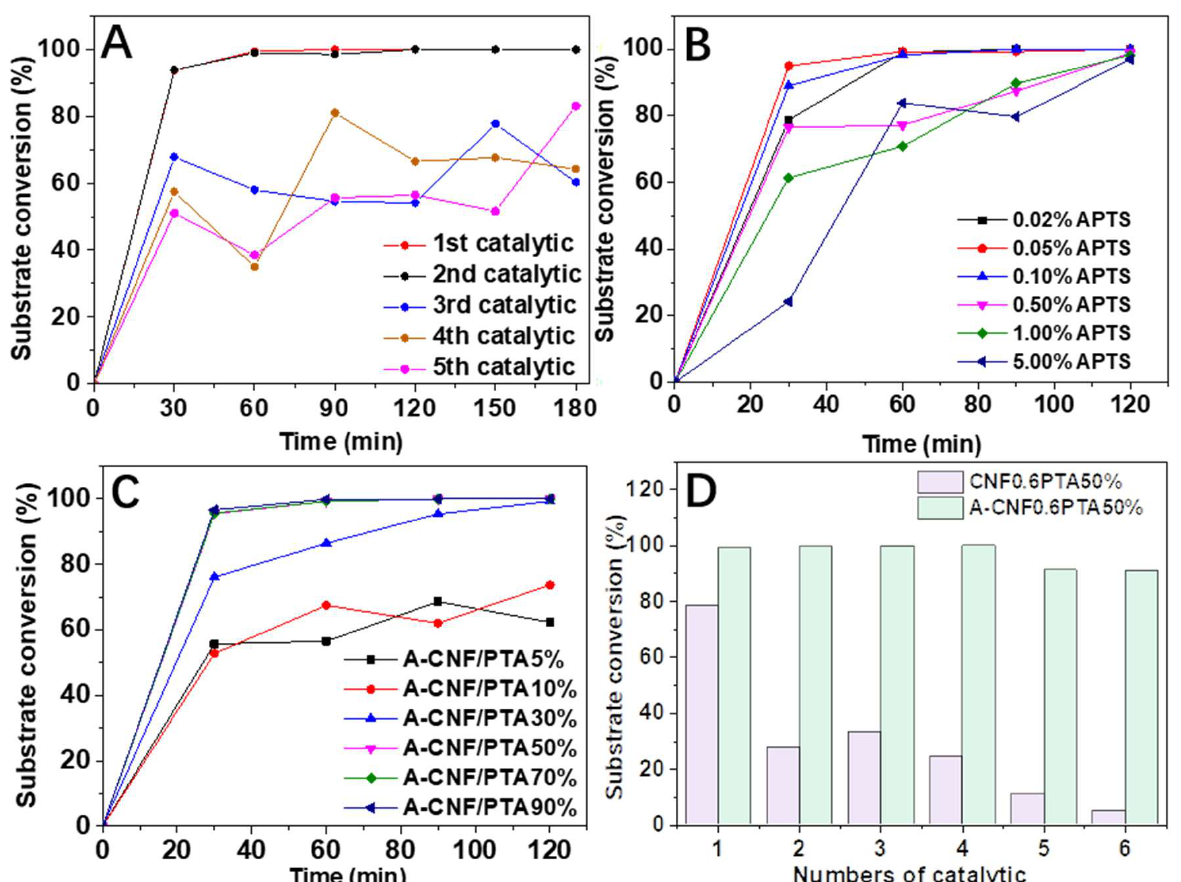
Figure 4. Cyclic catalytic performance of the aerogel CNF/PTA50% ( A ), catalytic performance of aminosilanized CNF aerogels ( B ), catalytic performance of A-CNF/PTA aerogels with different PTA content ( C ), cyclic catalytic performance contrast between the aerogels CNF/PTA50% and A-CNF/PTA50% ( D ).